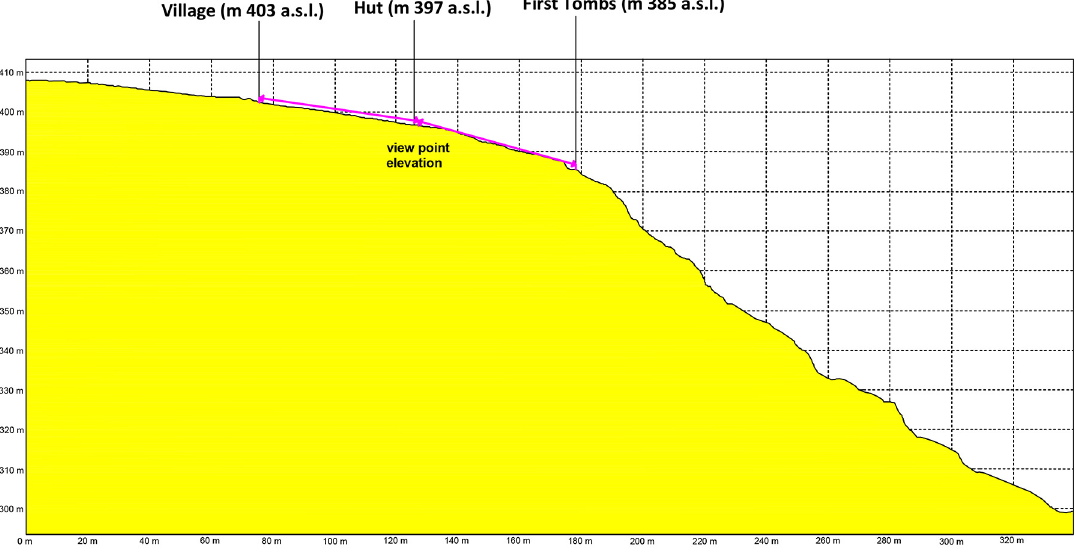
Figure 12. Profile of the slope with the height of villages, hut and necropolis, based on